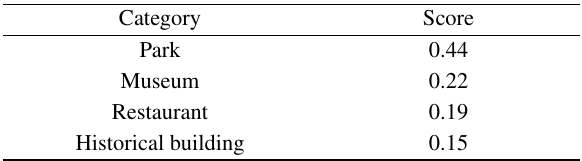
Table 7 Travel place category